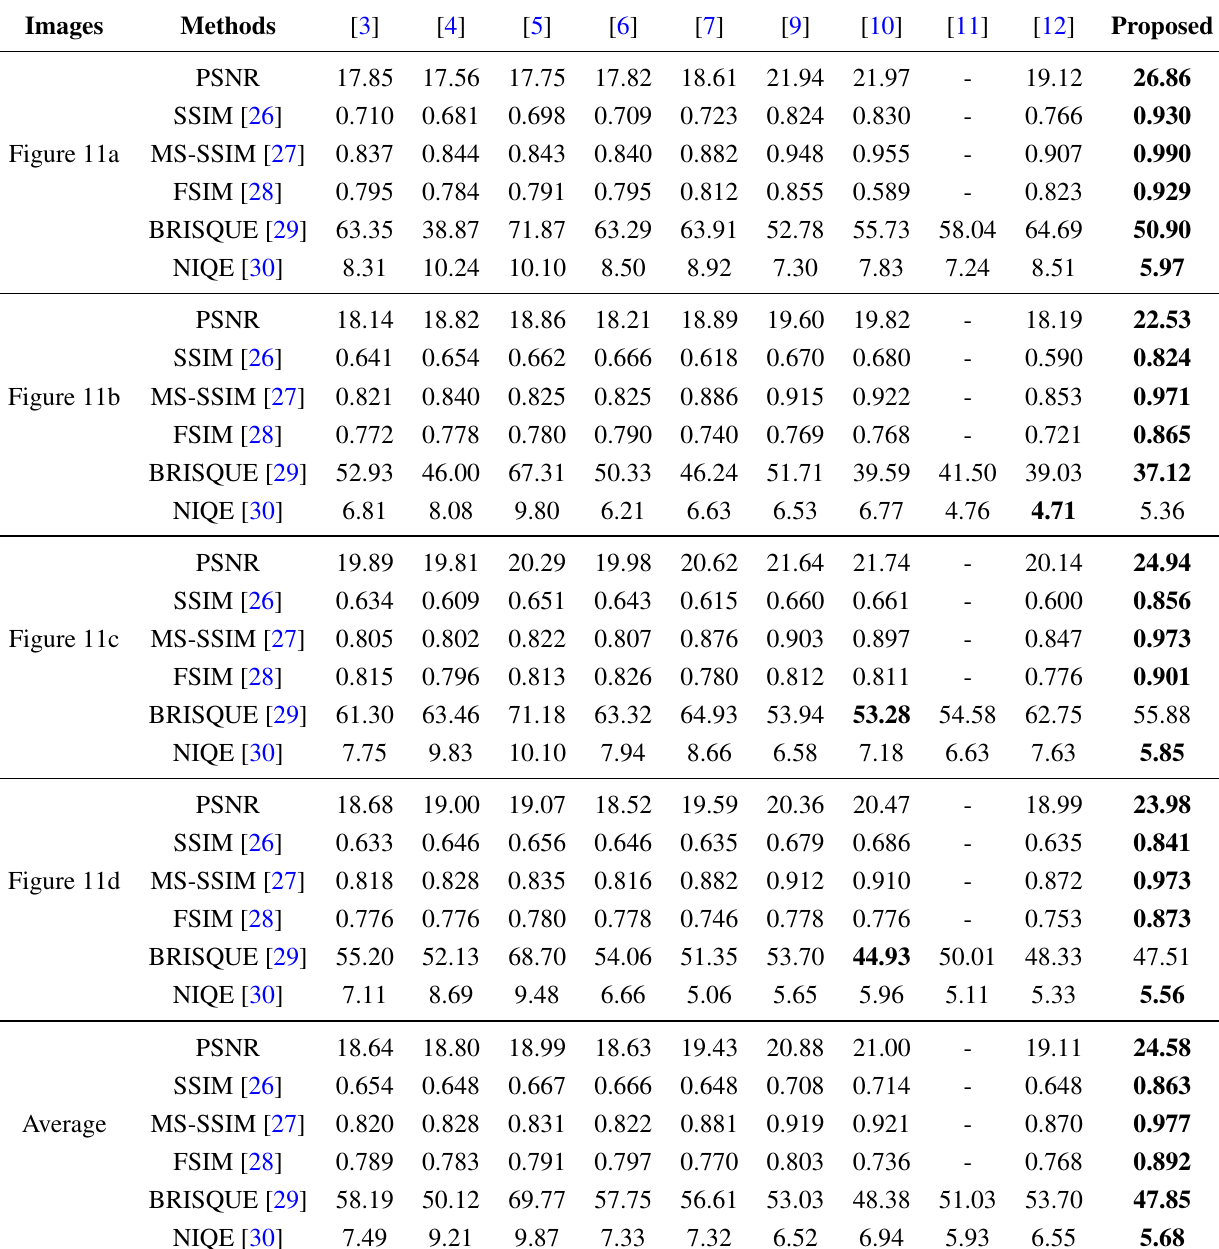
Table 3. Comparison of PSNR, SSIM, MS-SSIM, FSIM, BRISQUE and NIQE values of the resulting images shown in Figure 11 using nine existing and the proposed SR methods.